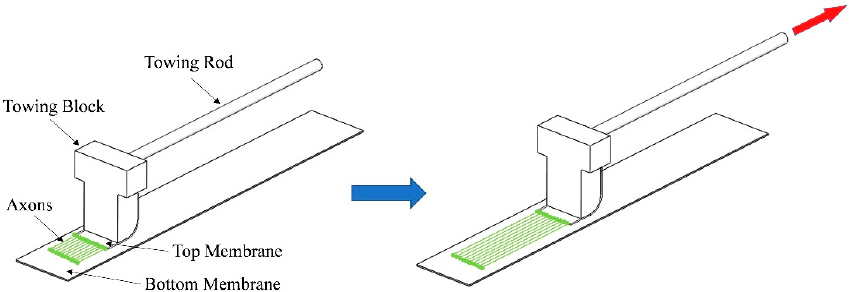
Figure 1. The working principle of two-dimensional axon stretch growth.